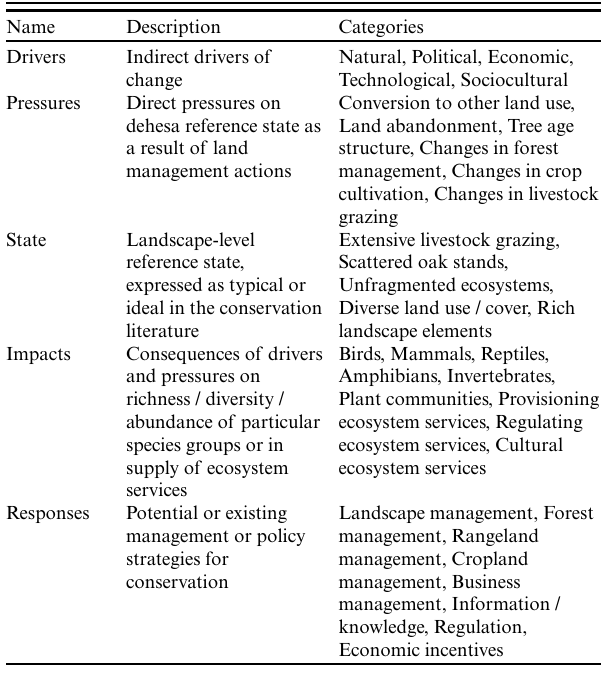
Table 2 . Categories used for coding drivers, pressures, state, impacts, and responses.